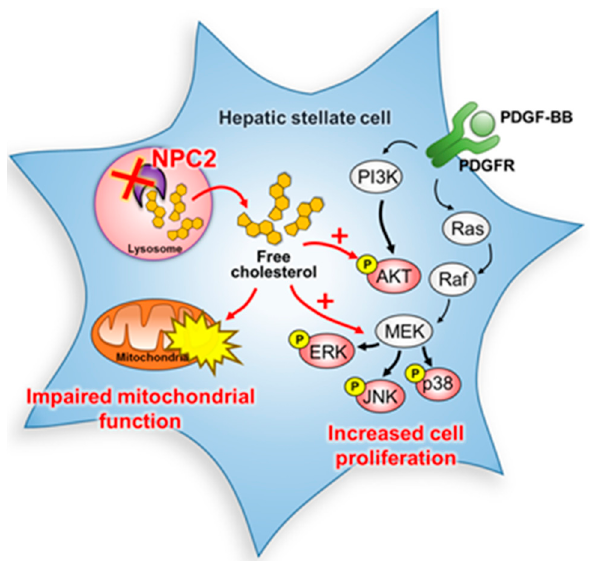
Figure 6. Schematic diagram of the signaling pathways involved in the downregulation of NPC2 in HSCs. Knockdown NPC2 in HSCs resulted in free cholesterol accumulation and enhanced the PDGF-BB-induced HSC proliferation by increasing the downstream proteins of MAPK and AKT phosphorylation. In addition, the mitochondrial respiration function was also impaired. ×, NPC2 downregulation. Black arrows, pathway signals. Red arrows and plus sign, proposed signals.